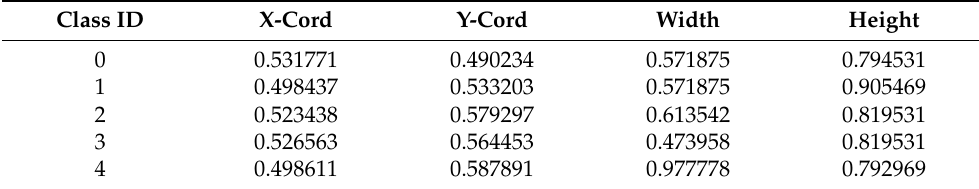
Table 1. Summary of data obtained from YOLO-labeled data file.